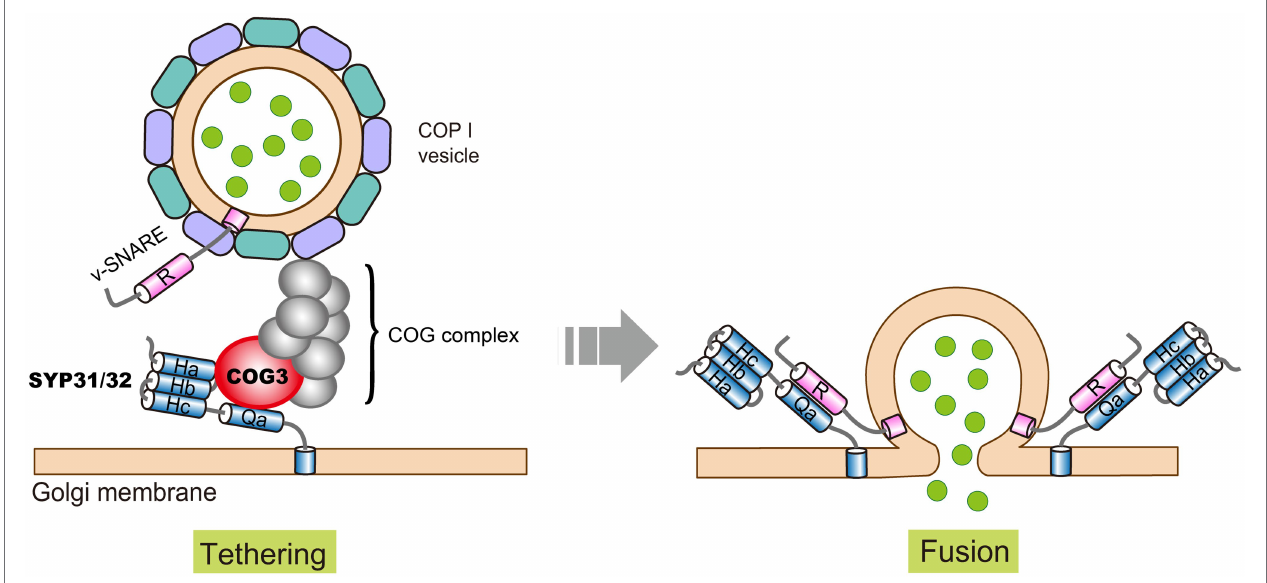
FIGURE 3 | A proposed model of intra-Golgi COPI vesicle tethering and fusion in Arabidopsis. Golgi-localized Qa-SNAREs SYP31/32 recruit COG3 to the Golgi membrane, and the other COG subunits were recruited by unknown mechanisms to form a complete COG complex. The COG complex tethers the incoming COPI vesicle, followed by vesicle fusion mediated by SNARE pairing. Please note that for simplicity, Qb and Qc SNAREs are not depicted